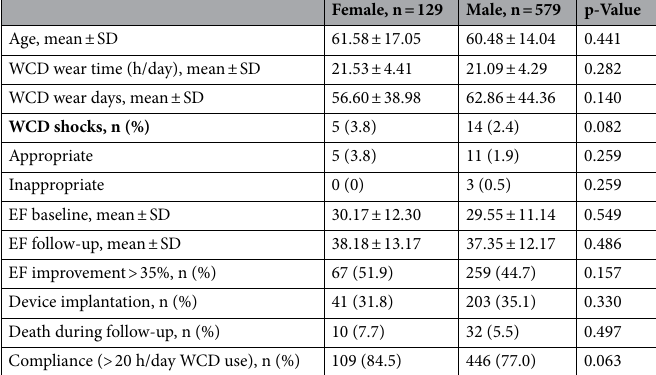
Table 2. Baseline characteristics of WCD patients stratified by sex.